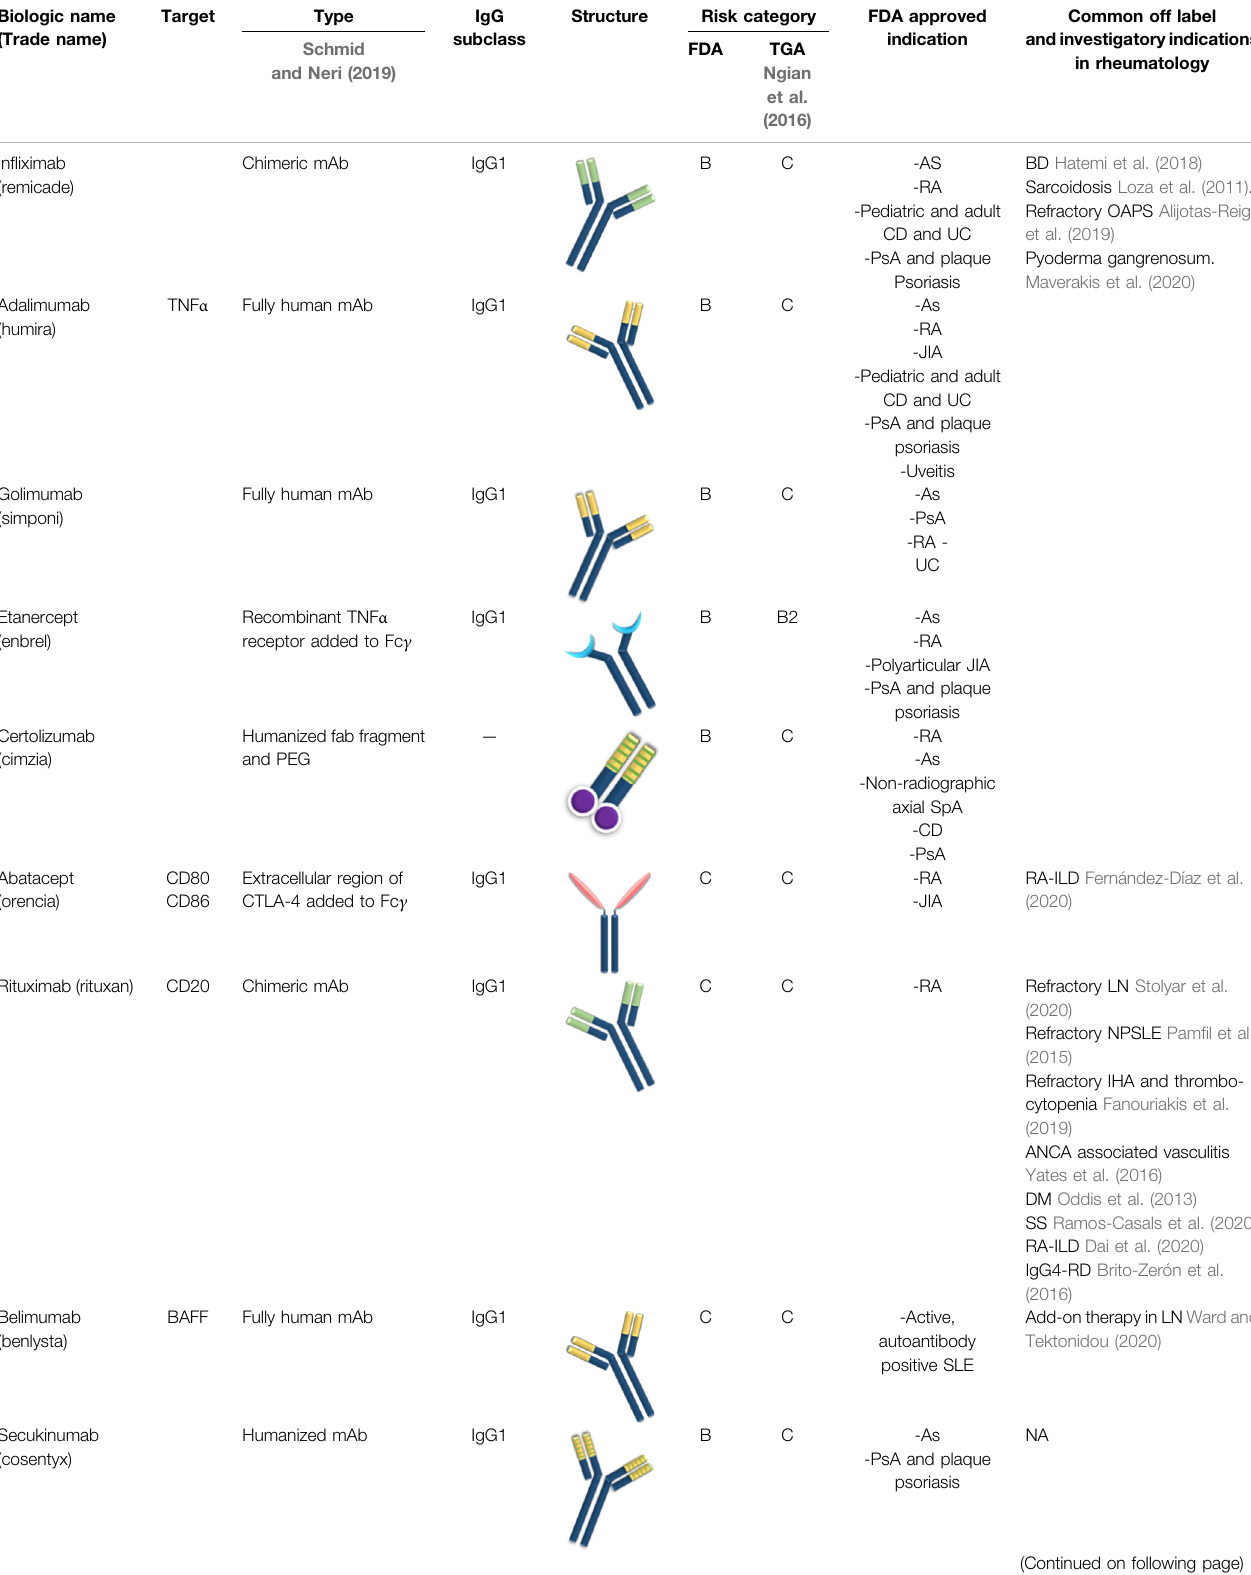
TABLE 1 | Common Biological Drugs in SARDs and their indications. Biologic name (Trade